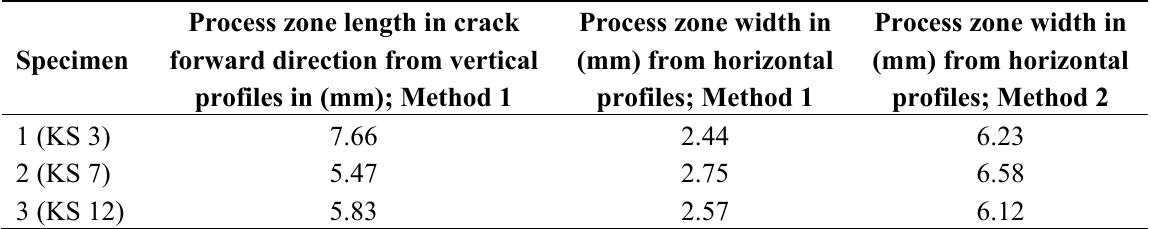
Table 3. Electronic speckle pattern interferometry (ESPI) results of process zone size r